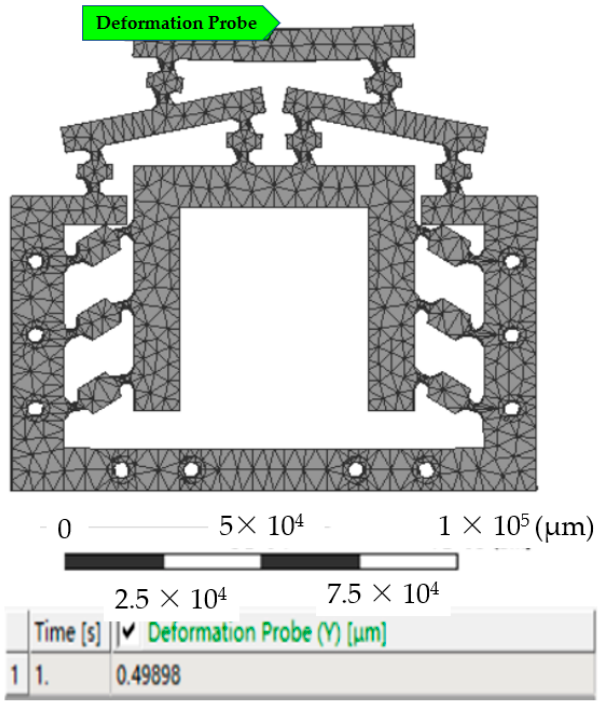
Figure 12. Kinematic analysis of the input displacement at 1 µm.